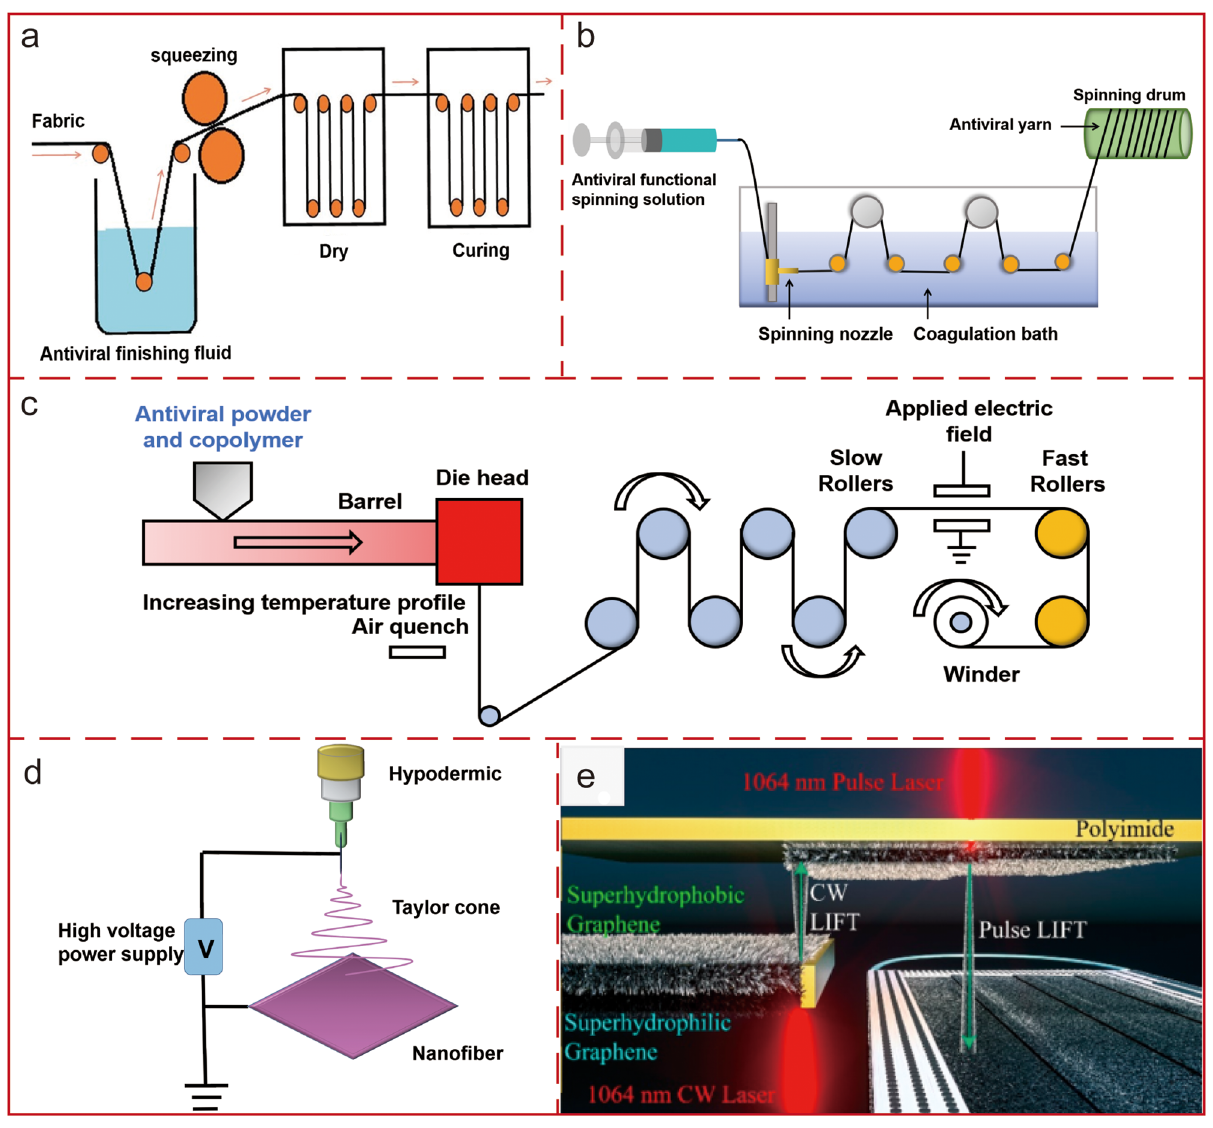
Figure 8: Methods of processing antiviral textiles. ( a ) Antivirus textile soaking and rolling process. ( b ) Preparation of antiviral textiles by wet spinning. ( c ) Antiviral textiles prepared by melt spinning. ( d ) Basic equipment for electrostatic spinning. ( e ) With CW - LIFT transfer of graphene onto a second polyimide and then pulse - LIFT transfer of graphene onto a temperature - sensitive mask [ 105 ]